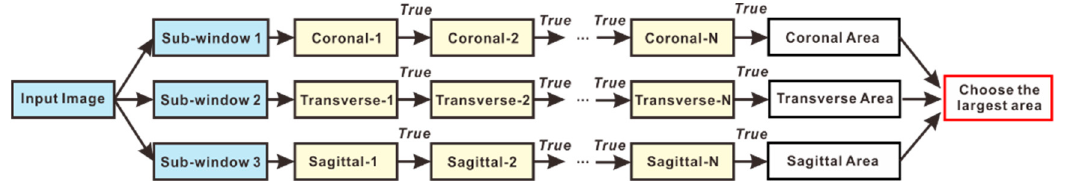
Figure 6. Cascade classifier stage to select anatomical plane orientation. Appl. Sci. 2019 , 9 , x FOR PEER REVIEW